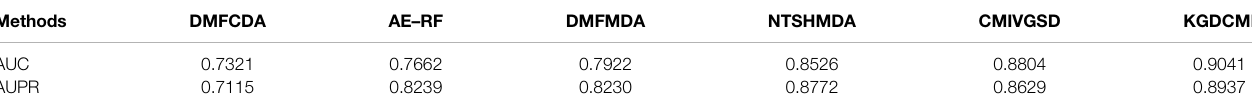
TABLE 2 | Performance comparison of fi ve methods based on fi ve-fold cross-validation.